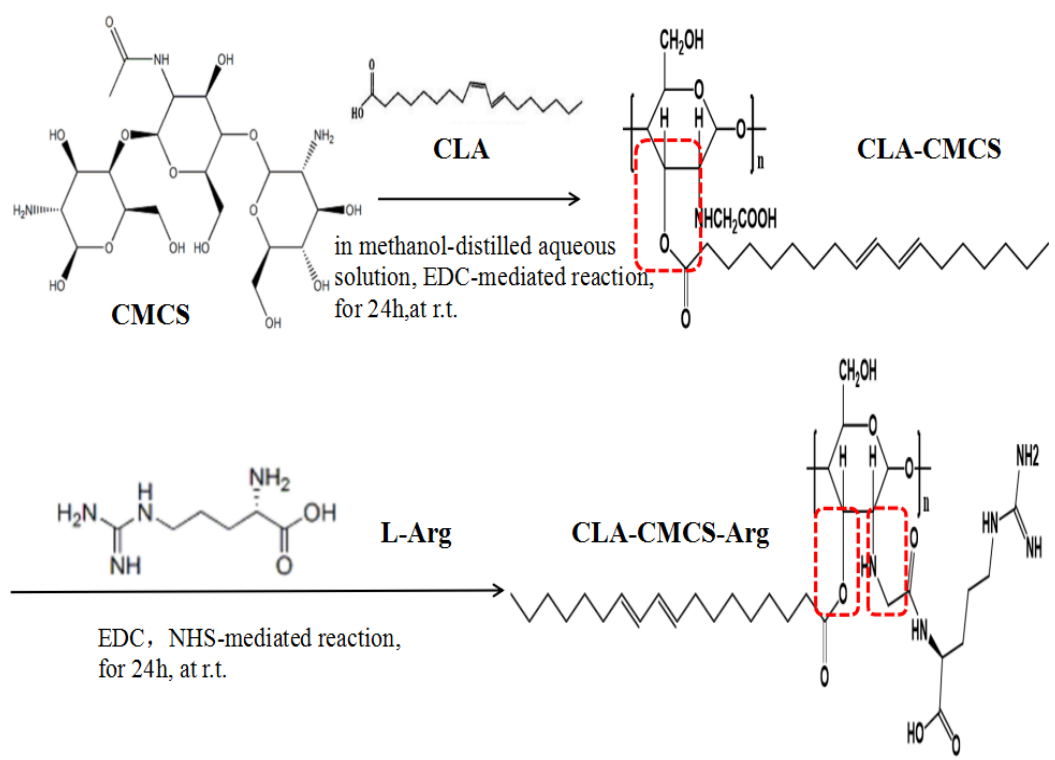
Figure 1. The schema of CLA-CMCS-Arg (CCA) synthesis.